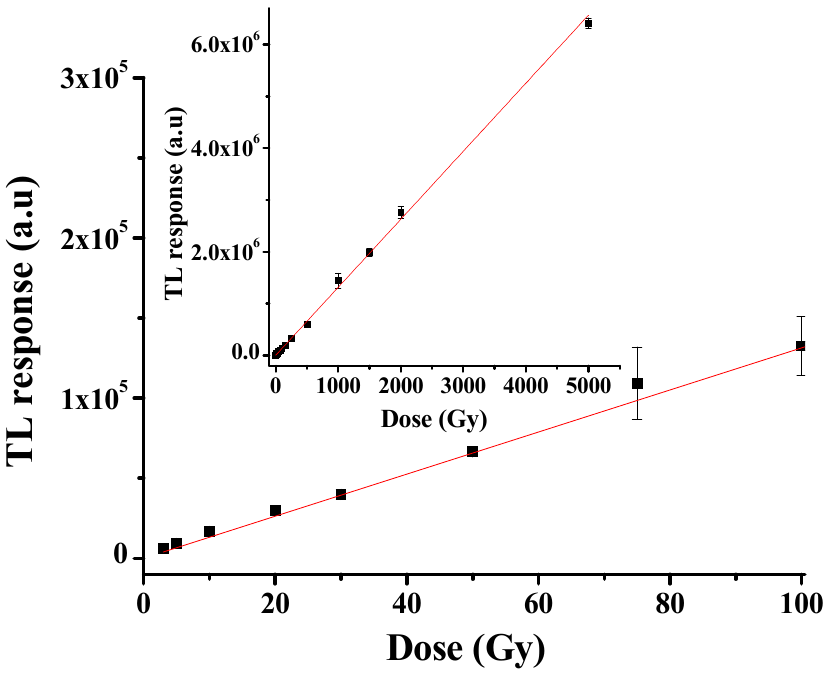
137 Cs source γ 4 O 7 :Zn glass S35654 for